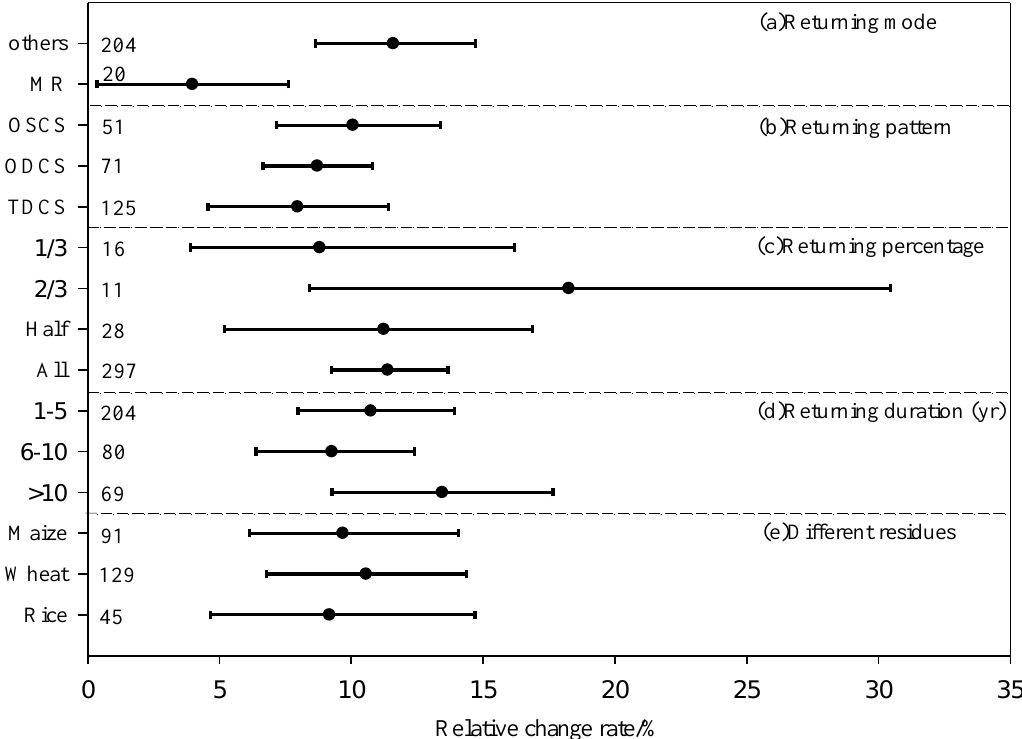
Figure 2. Relative change rate of SOC storage responding to residue retention. Others: other methods of RR, including residue chopping, evenly incorporating, and burying, etc.; MR: mulching retention; OSCS: returning one time in single cropping system; ODCS: returning one time in double cropping systems; TDCS: returning two times in double cropping systems; Half, half of the residues were returned; All, all residues were returned; Vertical axis represents invalid line, error bars represent 95% confidence intervals, the numbers to the right of the vertical axis are numbers of comparisons; if confidence intervals do not overlap with zero, it indicates significant increase (>0) or decrease (0) ( p < 0.05).